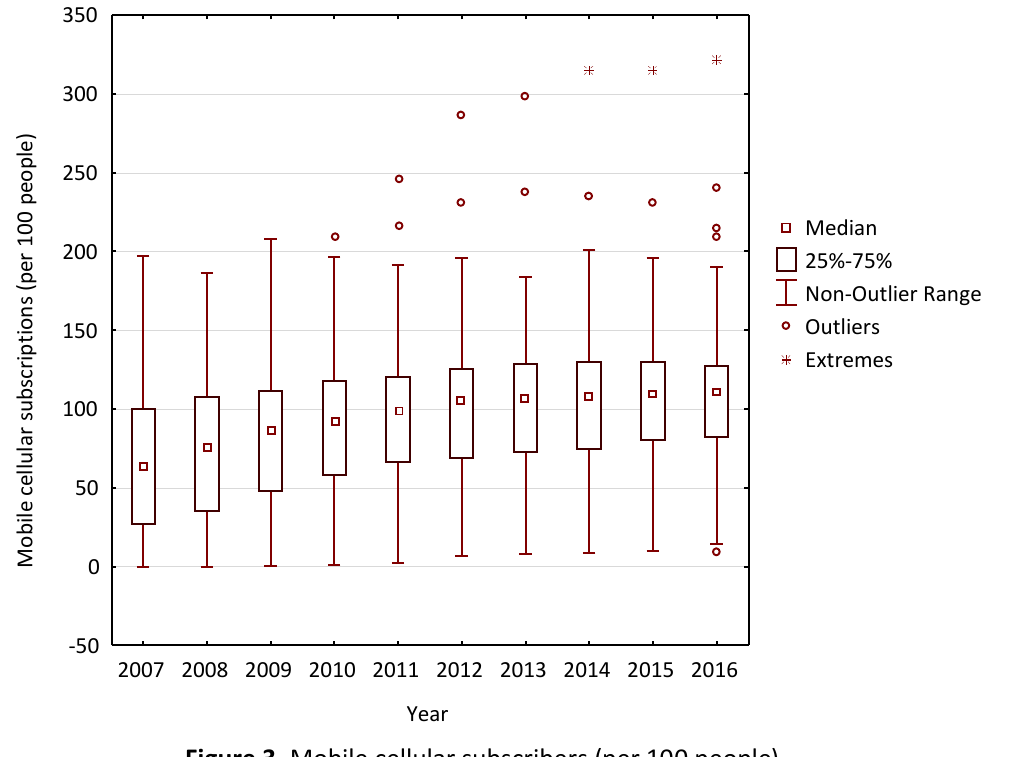
Figure 3. Mobile cellular subscribers (per 100